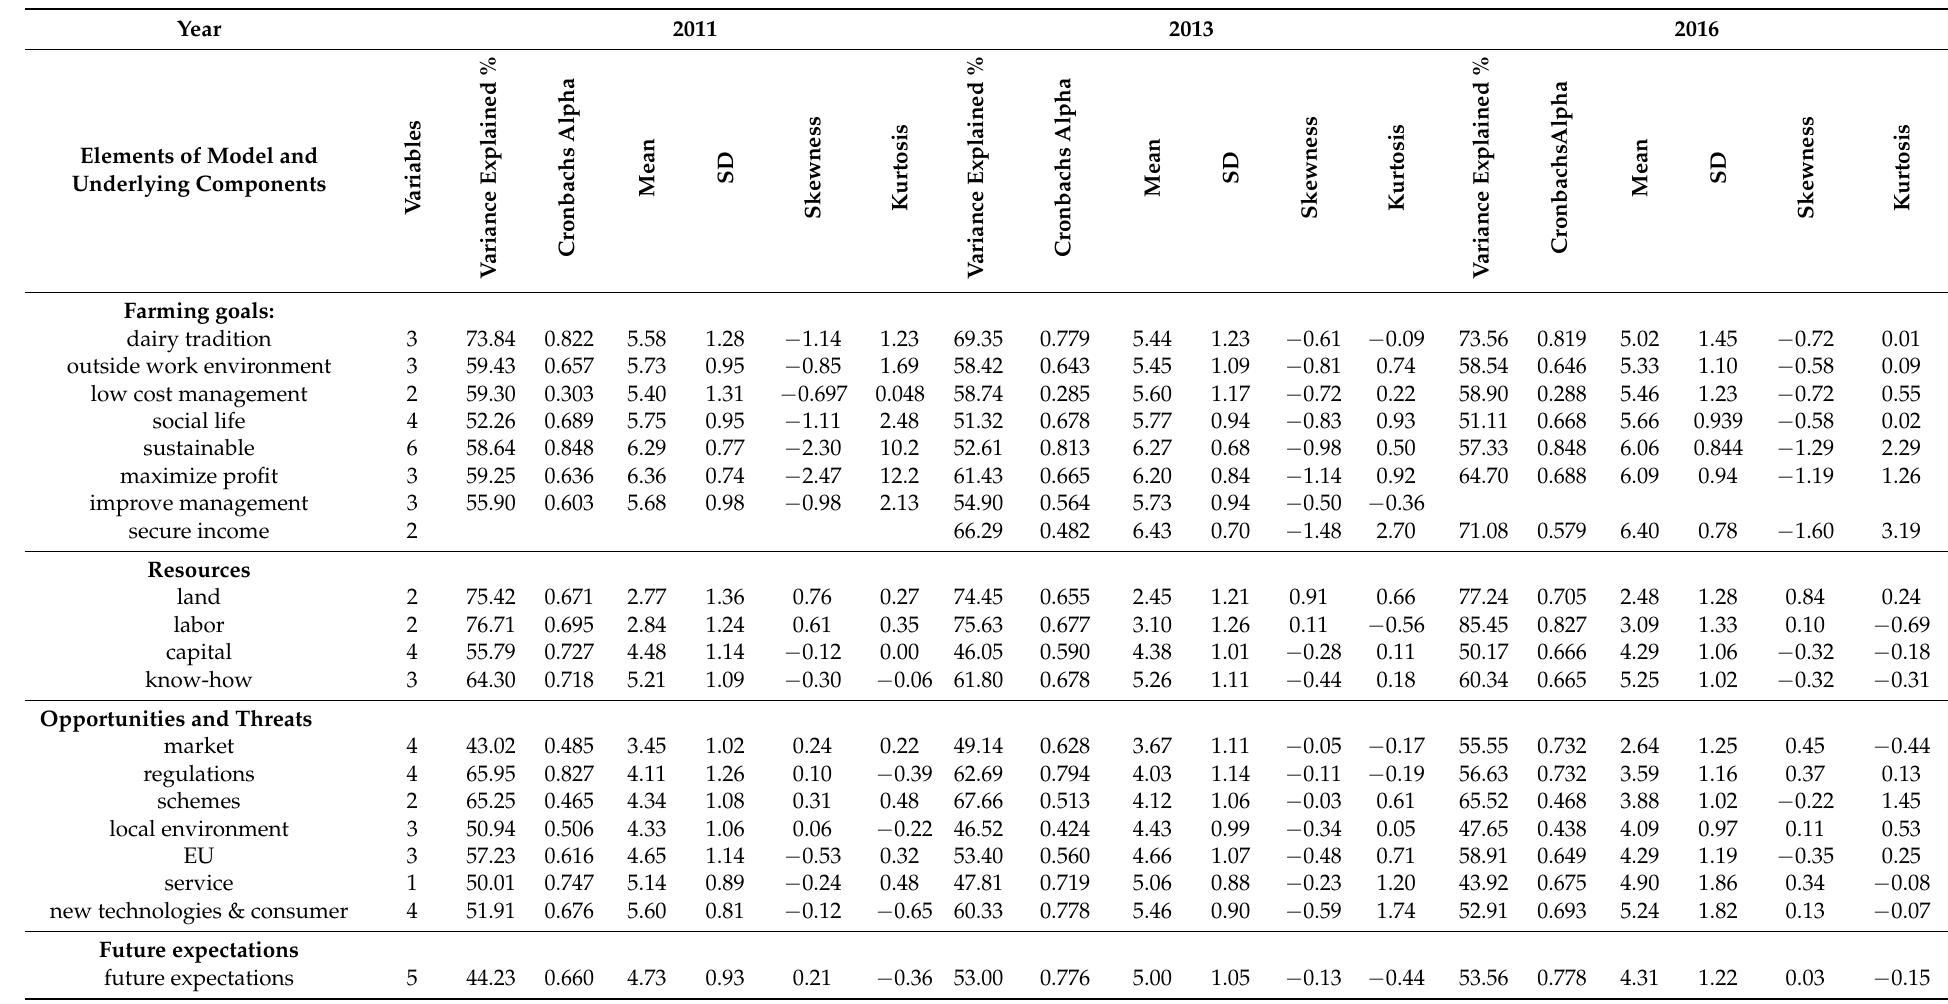
Table 4. Measurement properties of the elements in our model for year 2011 (CEE-countries; n = 218) and year 2013 and 2016 (all 4 countries; n =